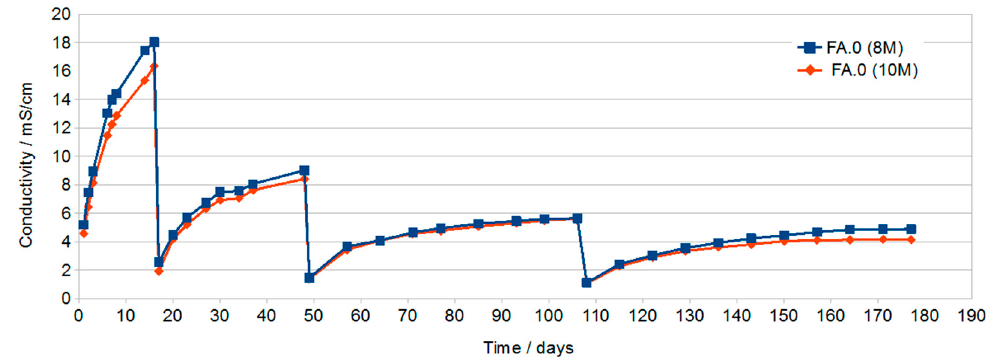
Figure 1. Of samples FA.0 (8 M) and FA.0 (10 M) as a function of immersion time with periodic water changes.